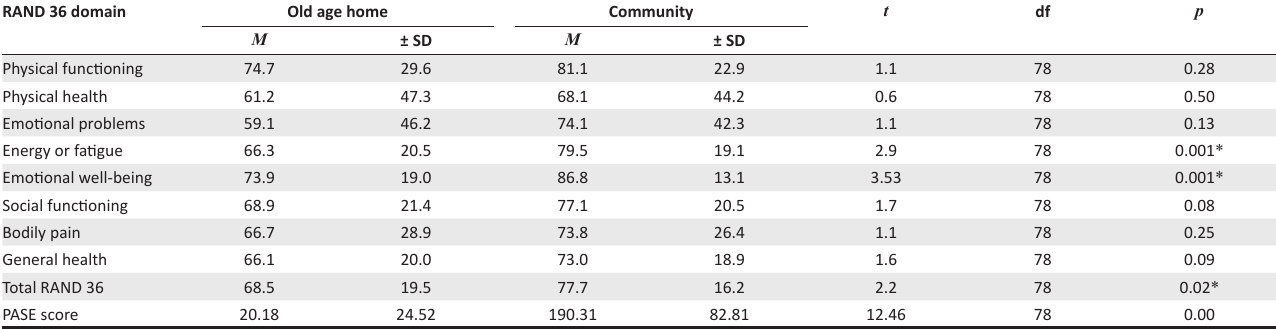
TABLE 2: RAND 36 domains and PASE scores ( n = 80).